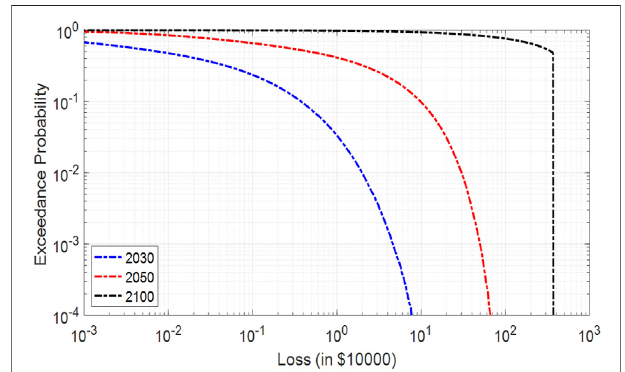
FIGURE 6 | The variation of exceedance probability corresponding to the loss for the years 2030, 2050, and 2100.